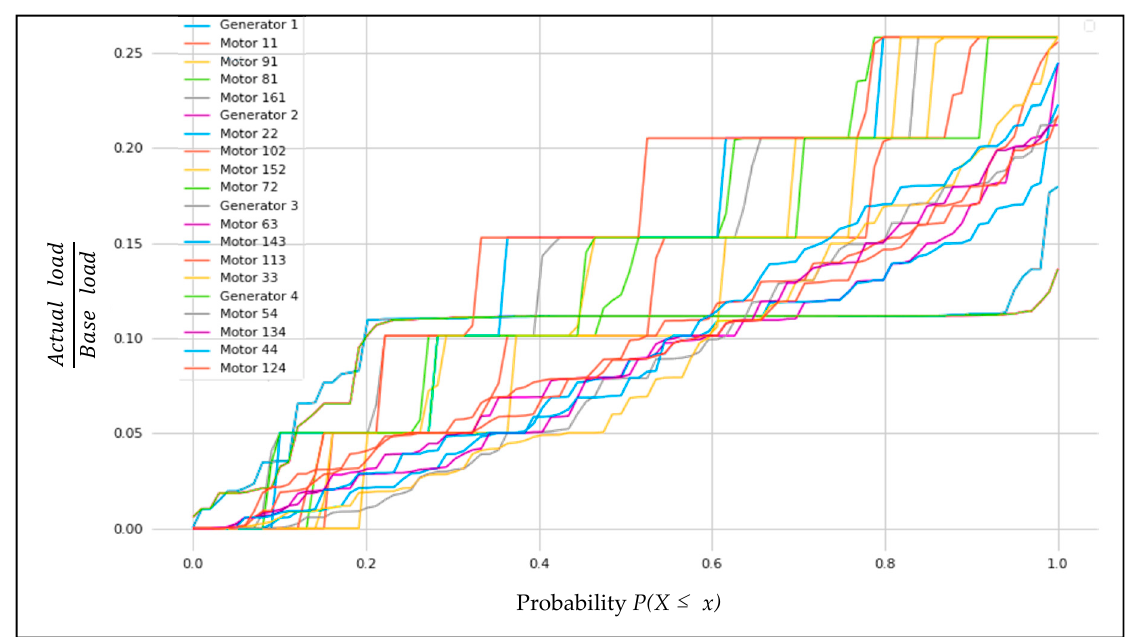
Figure 30. MC cruising branch load probability.